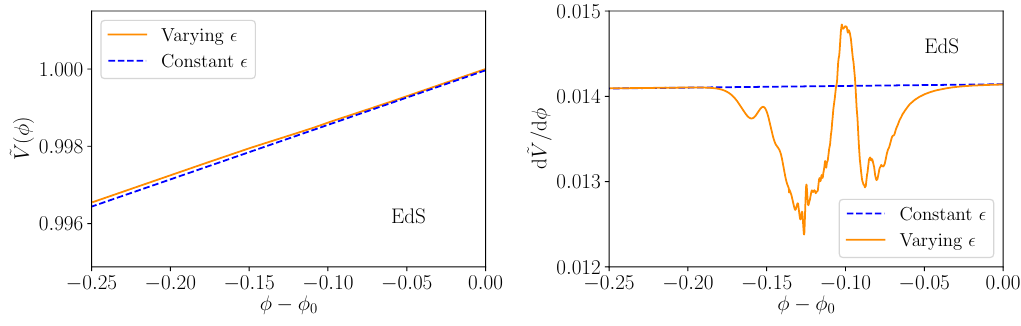
) corresponding to 0